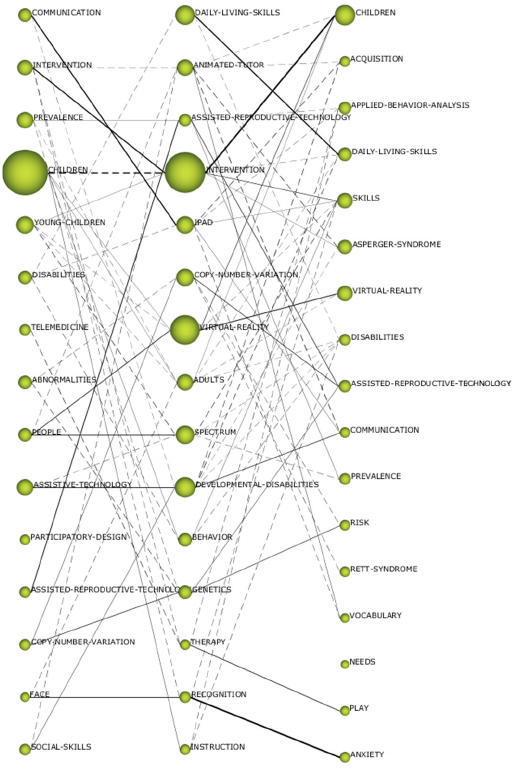
Figure 5. Thematic evolution by h-index.